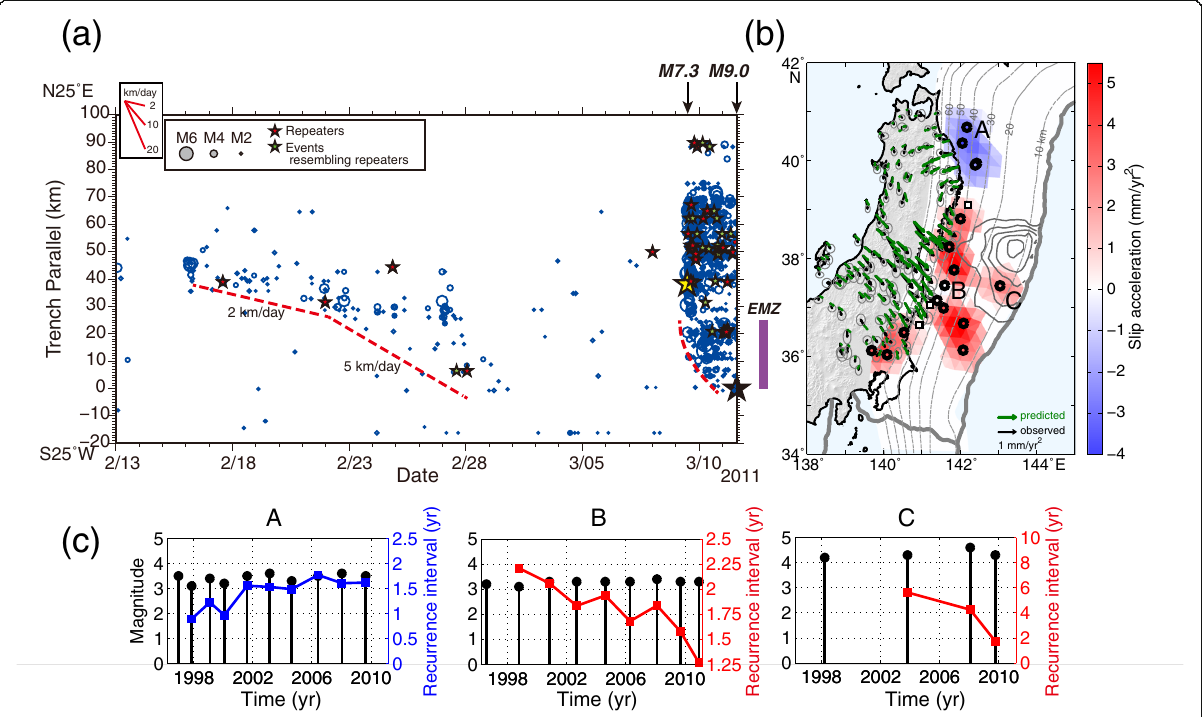
Fig. 13 Slow fault slip identified before the 2011 Tohoku-oki earthquake. a Two migrations of seismicity detected by the matched filter method within 1 month preceding the Tohoku-oki earthquake (after Kato et al. (2012)). Repeaters in the seismicity (stars) suggest the involvement of slow fault slip. b Long term (1996 – 2011) slip rate accelerations estimated from GPS and repeaters (after Mavrommatis et al. (2015). Colored circles show the locations of repeater sequences that showed statistically significant monotonic trends in recurrence interval during the study period. Observed GPS accelerations shown as black arrows with 2 σ error ellipses, predicted in green. c Examples of repeater activity for three sequences shown in b (after Mavrommatis et al. (2015). The black bars and circles show the magnitude and timing of events and colored lines show recurrence intervals from the preceding event